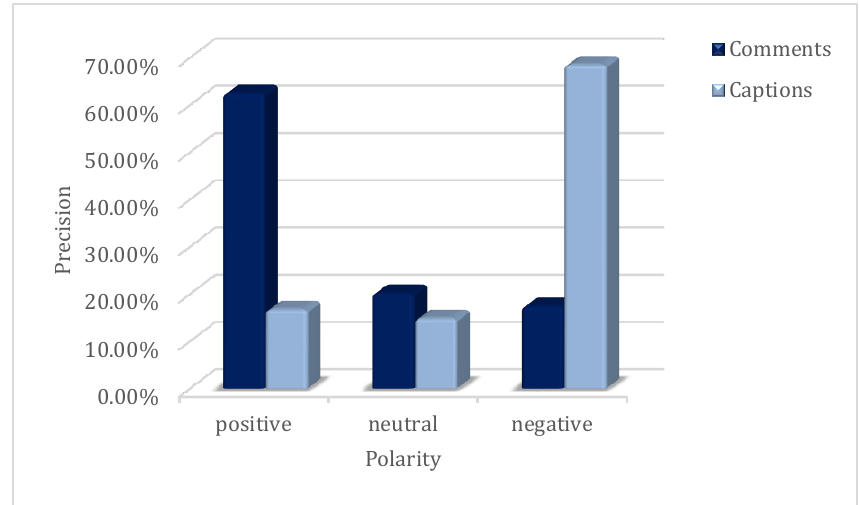
Figure 11. Comparison of the sentiments of the comments and captions in %age.